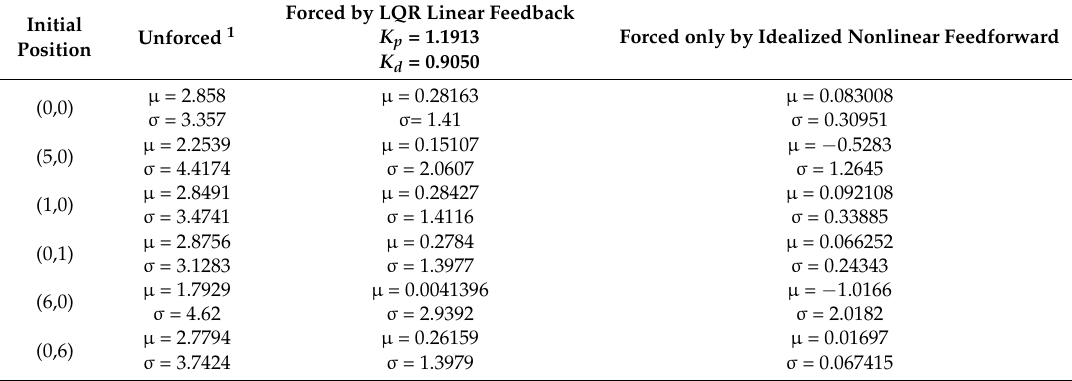
Table 1. Comparison of forcing method (non-optimal observers).